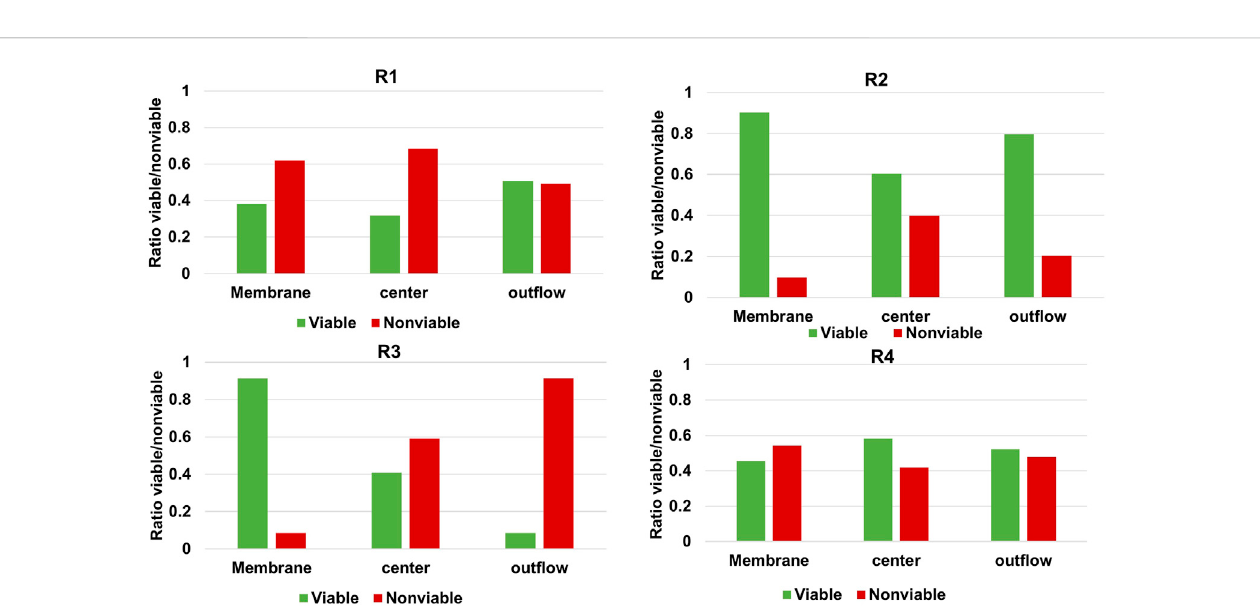
FIGURE 3 Relative abundance of live and dead microorganisms in the cathodic bio fi lm of each MES reactor at three different locations of the carbon